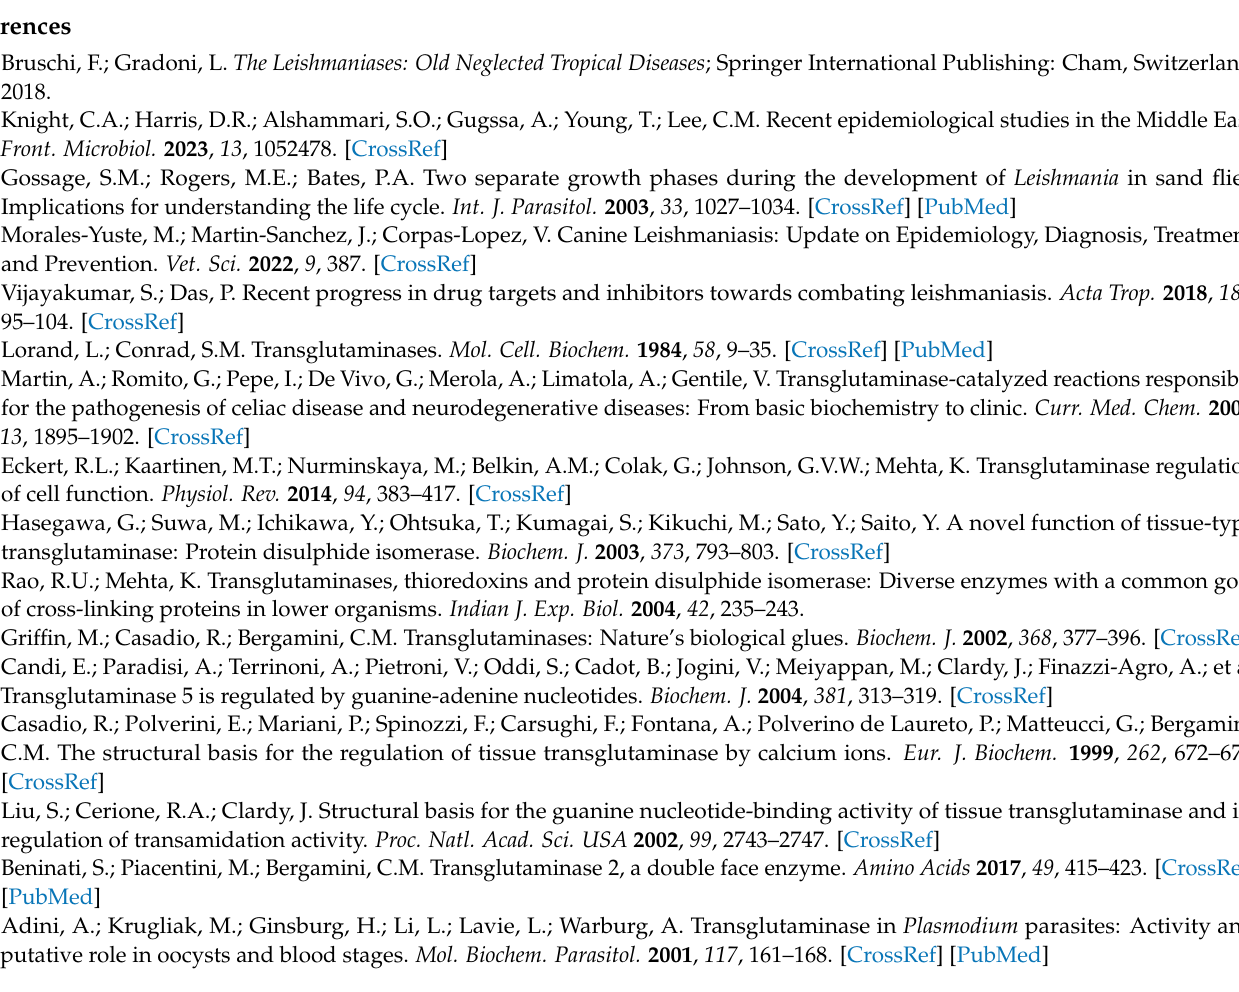
Figure S2: WB full membrane for Figure